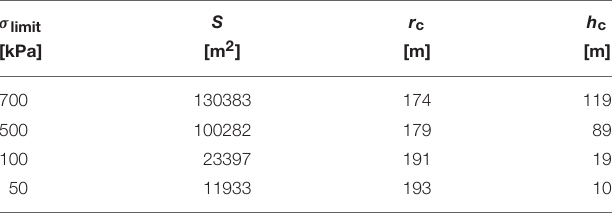
TABLE 1 | Space station dimensions r c , h c , and usable area S for model 2 stress estimates and material strength σ limit . See text for details. σ